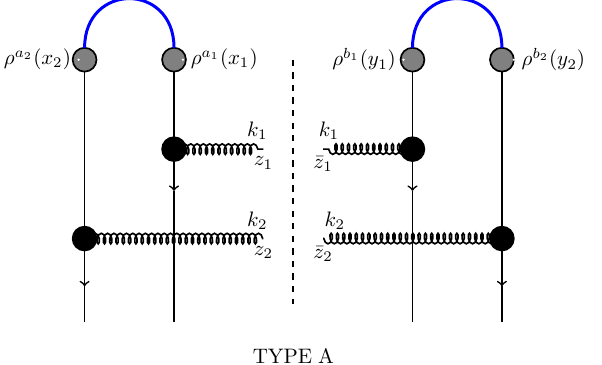
Fig. 2 Diagrams of type A, Eq. (11)